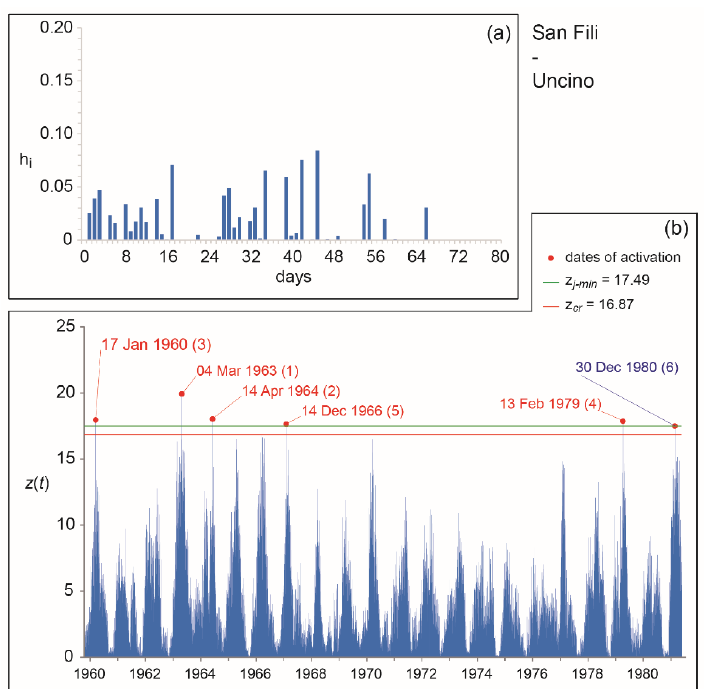
Figure 9. San Fili—Uncino case study: ( a ) optimal kernel; ( b ) mobility function obtained by applying the optimal kernel to the entire set of available activation dates (cf. [17]).